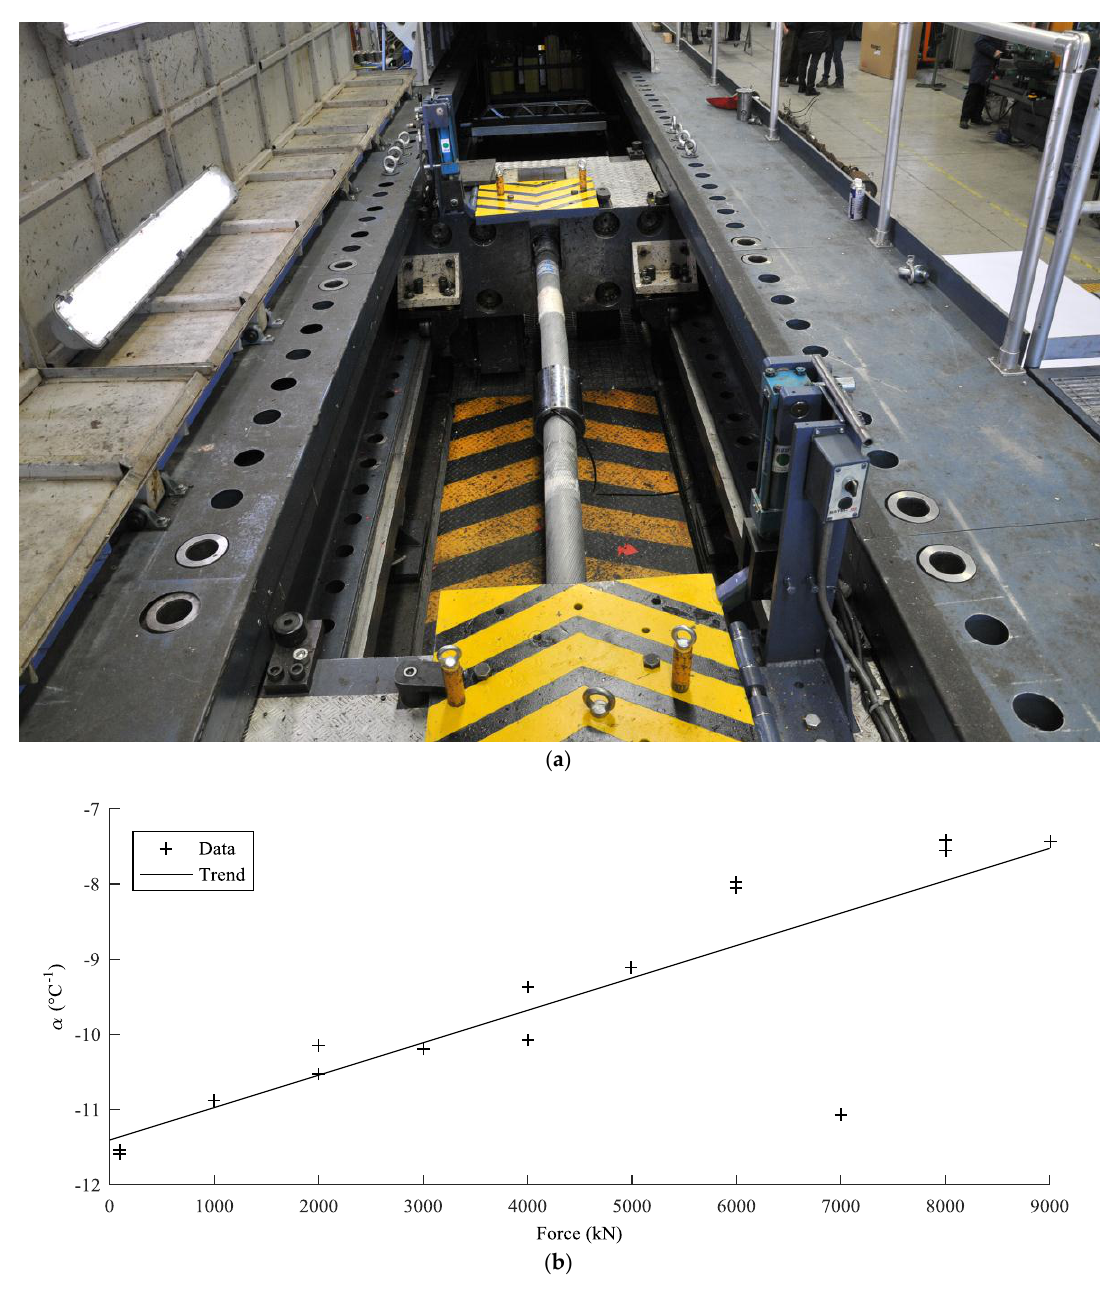
Figure 3. ( a ) View of an EM sensor on a 116-mm cable during laboratory calibration; ( b ) permeability sensitivity α (to temperature) for the cable of diameter 128 mm; the coefficient varies with the load level.